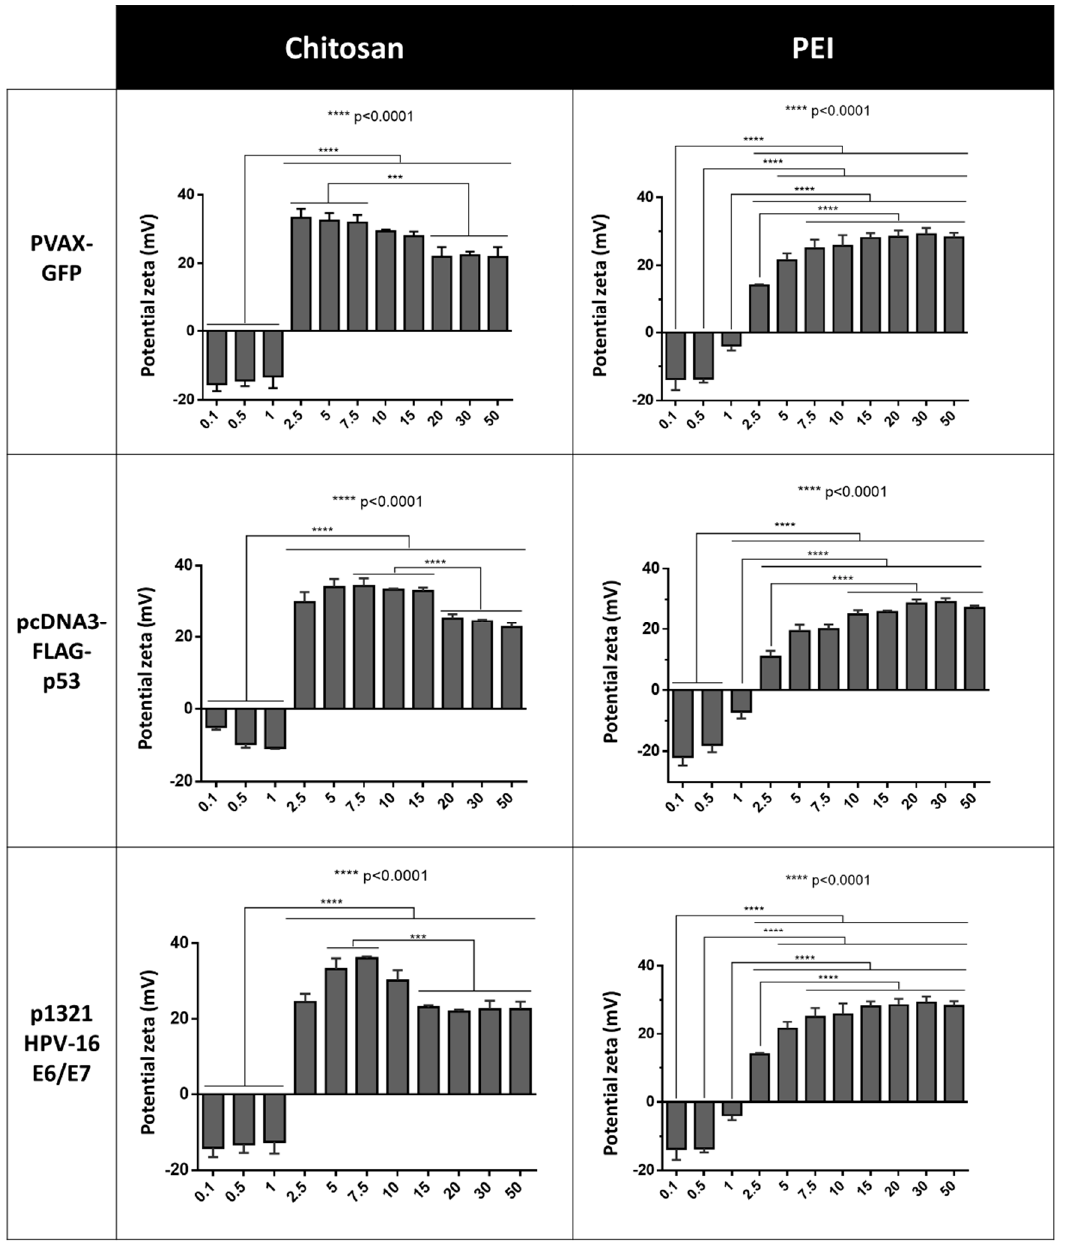
Figure 2. Zeta potential measurements for the different polyplexes. The asterisks indicate a statistically significant difference in the zeta potential between the polyplexes produced with the different polymer ratio studied. Data are presented as mean ± S.D., n =